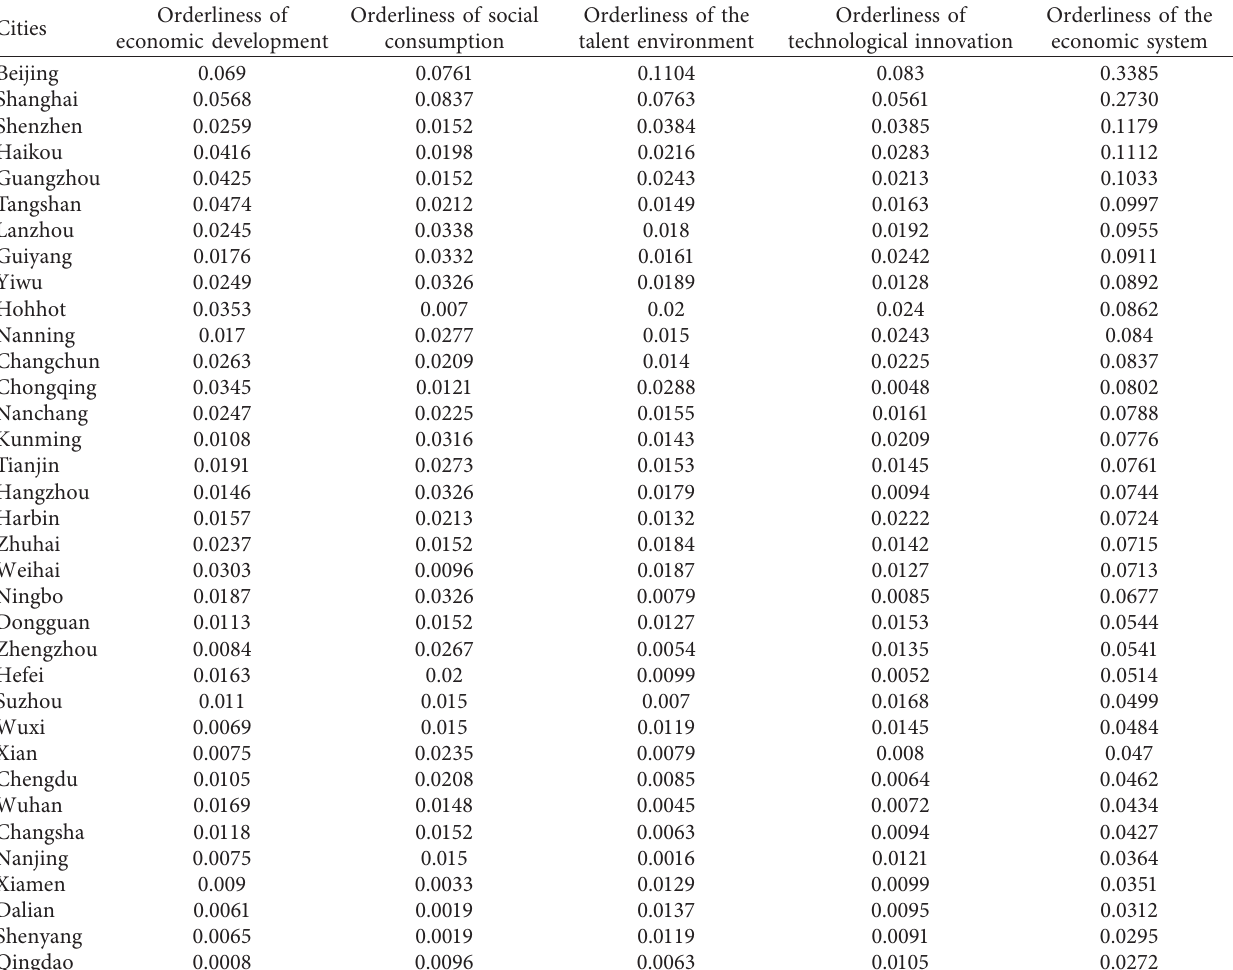
Table 5: Orderliness of the economic system of the cities where the CBECCPAs